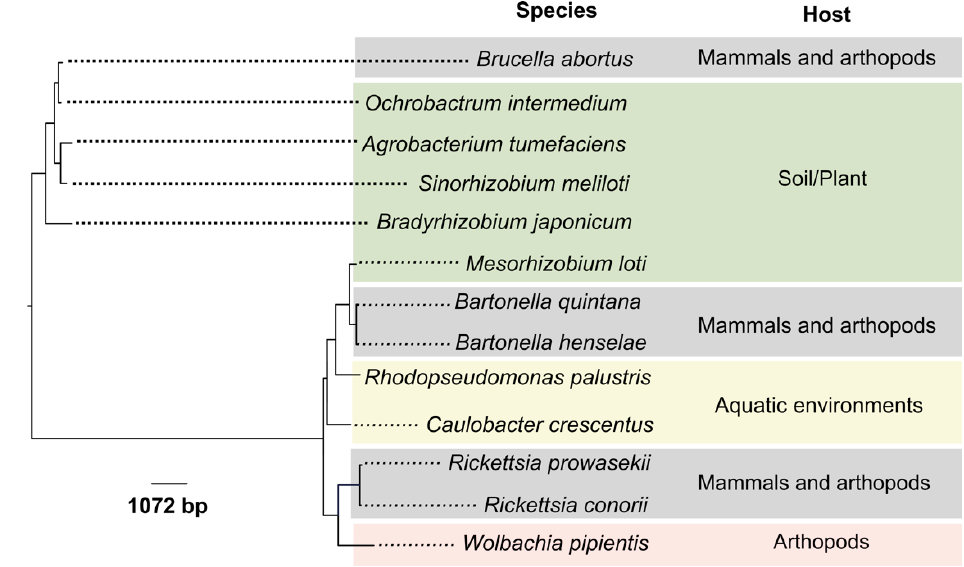
Figure 1. The phylogeny of some representative Alphaproteobacteria inferred by maximum likelihood reconstruction based on the 16S rRNA gene. The sequences used as outgroup [14] were trimmed out from the tree to enhance the resolution. The analysis involved 17 nucleotide sequences; there were a total of 1191 positions in the final dataset. Table S1 indicates the details of the strains and sequences used for the analysis. Ochrobactrum intermedium may behave as opportunistic bacteria in immunocompromised human hosts [15,16].